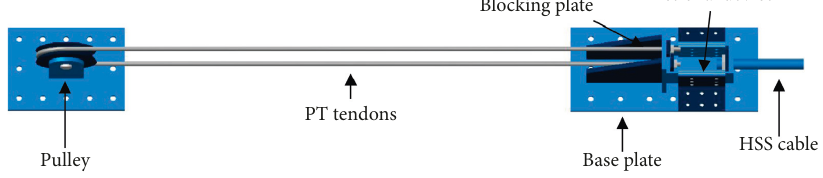
Figure 1: Schematic of SC-TOB.